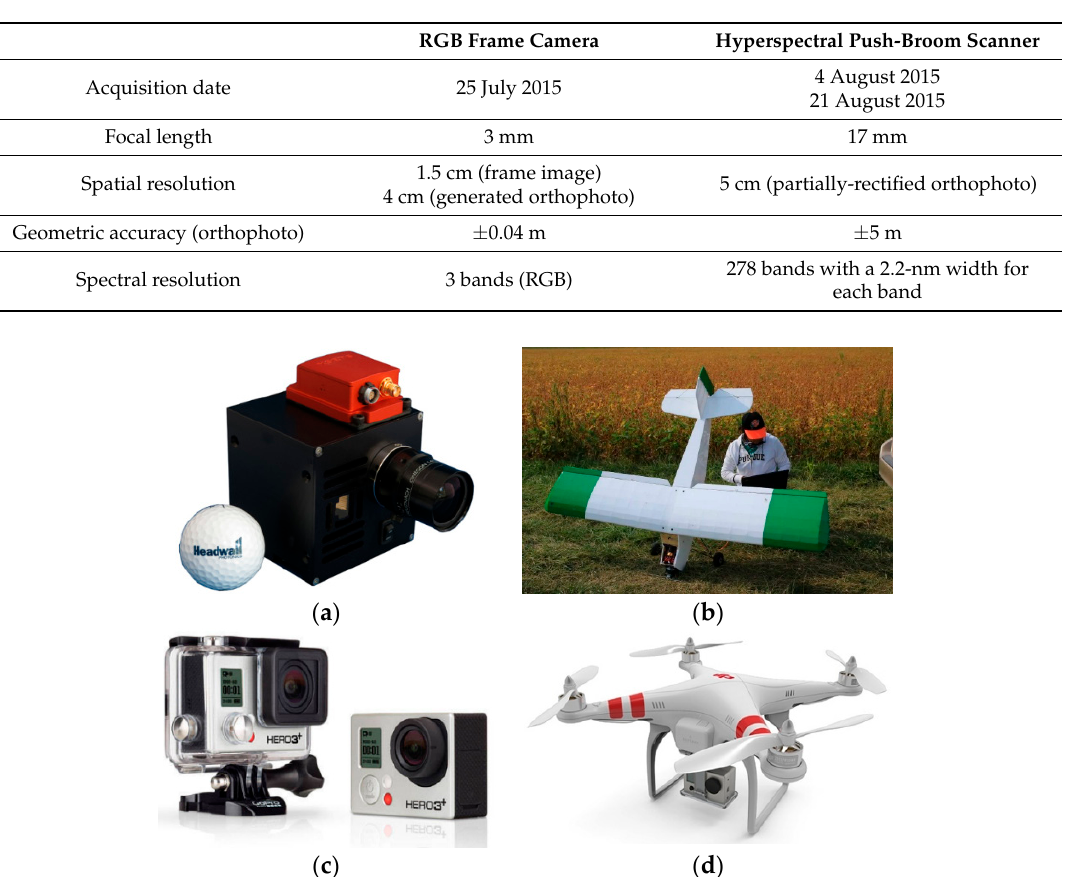
Table 1. Specifications of RGB and hyperspectral imaging sensors